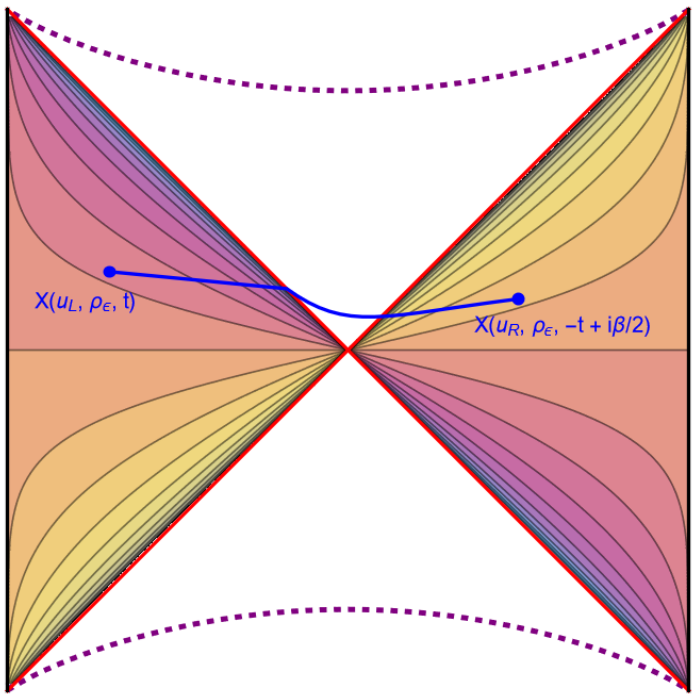
Figure 5 . An AdS Penrose diagram shows a cartoon projection of the Hartman-Maldacena surface in blue, connecting our two bipartition points, on the left- and right-universe patches (left- and right-exterior). The Penrose diagram is shown as a projection onto a constant ρ = ρ (cid:15) slice, where the purple dashed line is the singularity at u = ∞ , the red diagonal lines are the event horizon at u = u H , and the black borders on the left and right represent the defect at u = 0 . The color-gradient contours show the constant time-slices and reversed direction of the time-like Killing vector field on each side of the black hole. Notice that in this diagram, u L 6 = u R , and the HM surface is not symmetric across the event horizon. Also note that the HM surface is not confined to this diagram since it generically varies in the coordinate ρ